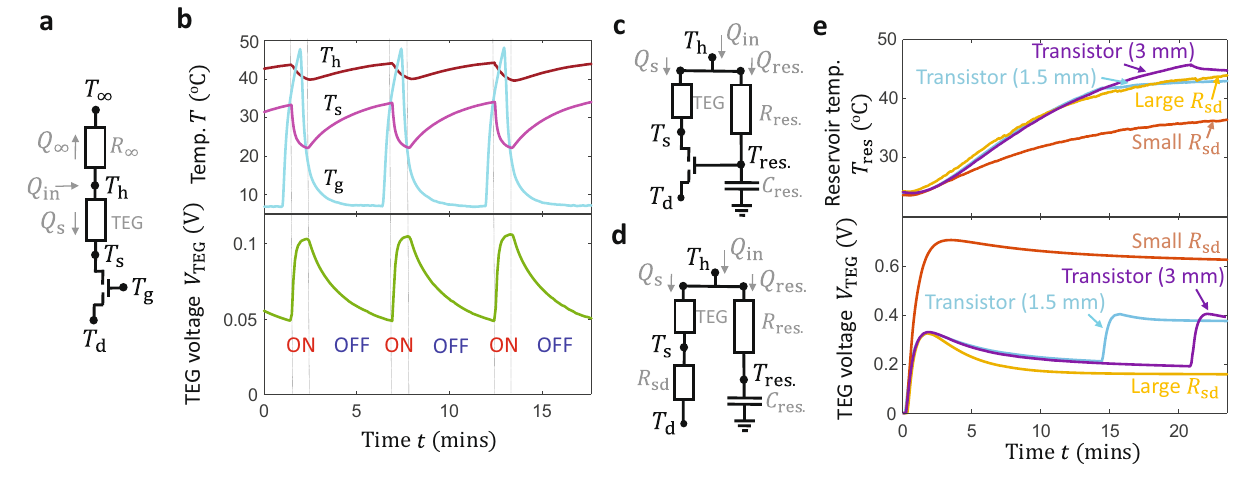
c directs the input heat fl ow Q in to a thermal reservoir when the reservoir tem- perature T res islow,whileredirecting Q in topassthroughaTEGandgeneratepower when T res ishigh. e Thetransistorallowsthesystemtosimultaneouslyachievelarge steady-state T res >40 o C (top, cyan) and large steady-state V TEG >0 : 4V (bottom, cyan), combining bene fi cial aspects of the small- R sd (red) and large- R sd (yellow) cases. The transition switching temperature T off (cid:3) on controls the steady-state reservoirtemperature, and can be increasedfrom 41°C to 46°C by increasing the gap size between the shuttle and the gate terminal from 1.5mm (cyan) to 3mm